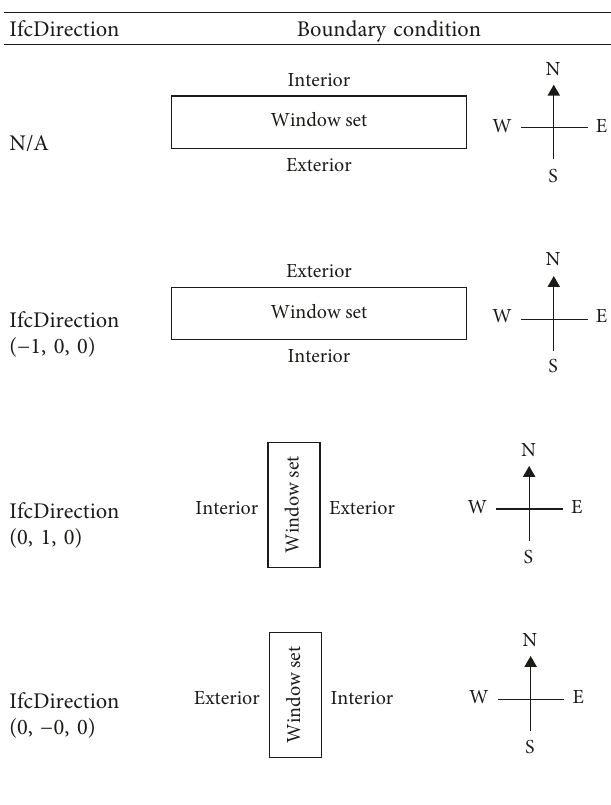
Table 1: Boundary condition determination by IfcDirection.